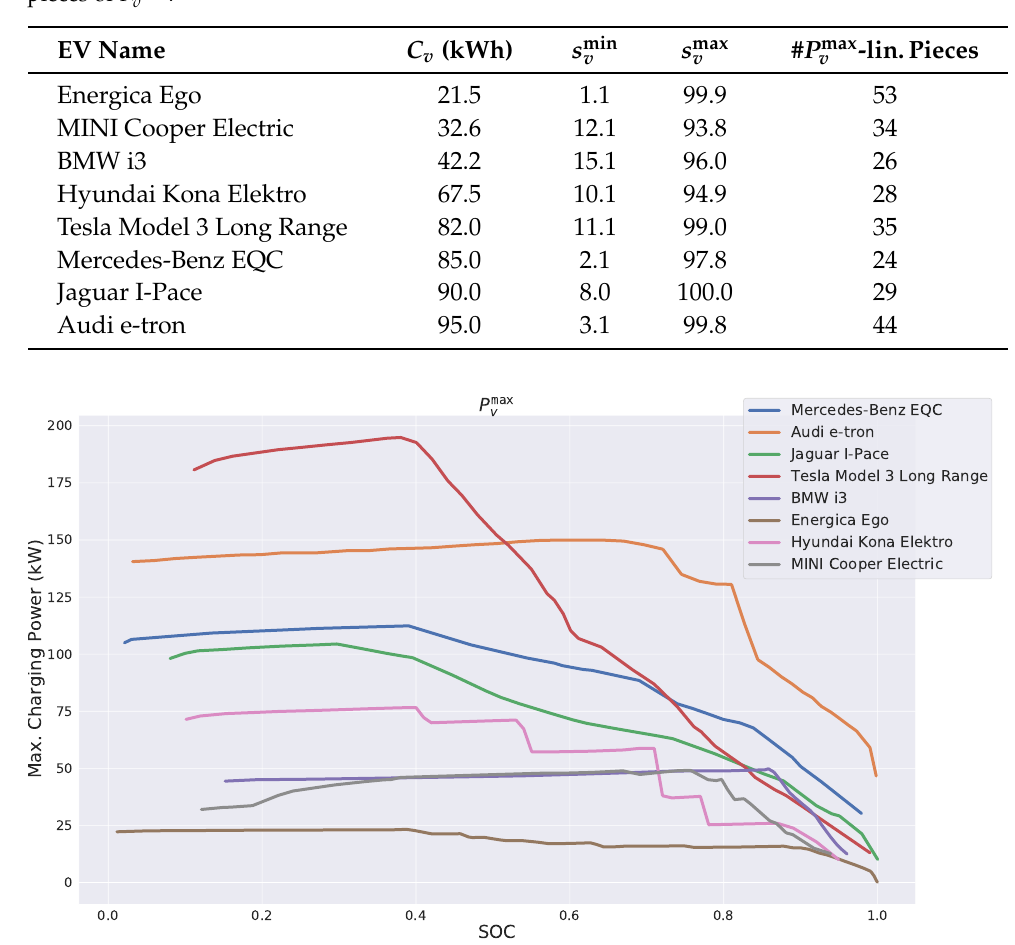
Figure 3. Maximum charging power functions P max v for all considered vehicle